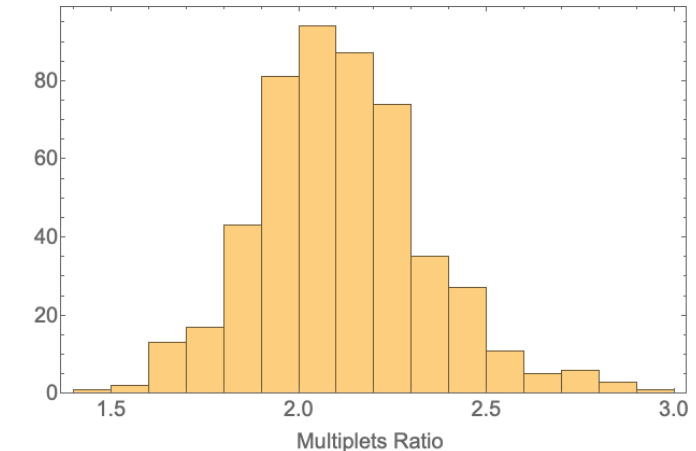
Figure 5. Histogram of ratios between number of multiplets identified in 100,000 years simulated catalog and 500 randomizations of same